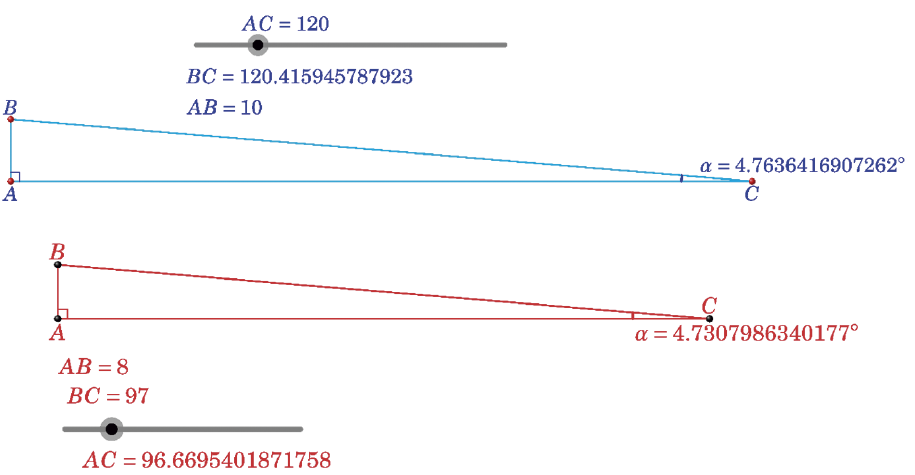
Figure 7. Worksheet 5. The technical drawing of groups on Geogebra